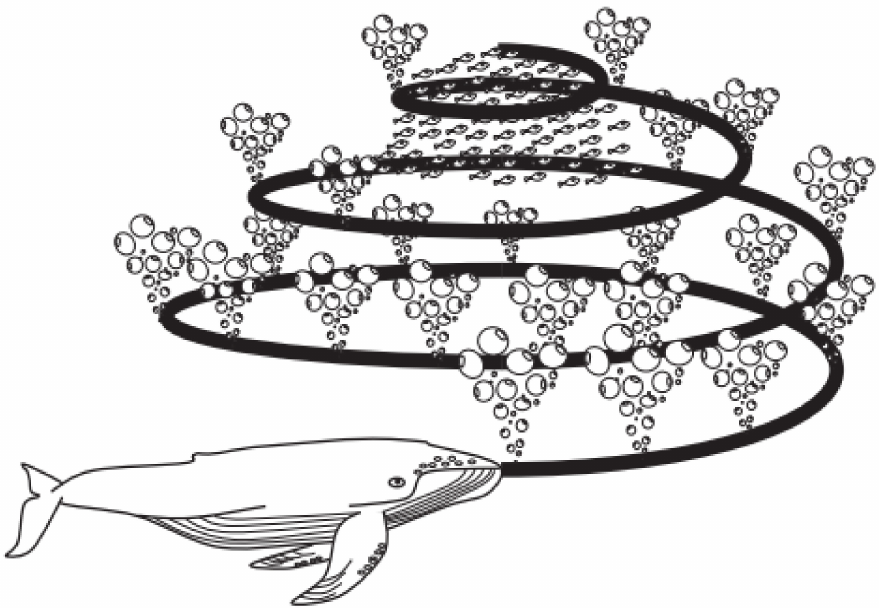
Figure 5. Bubble-net hunting behavior of humpback whales.